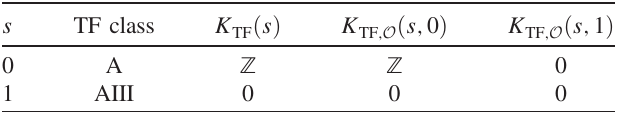
TABLE XXV. The groups K for complex Shiozaki-Sato classes with a unitary order-two (anti) symmetry.